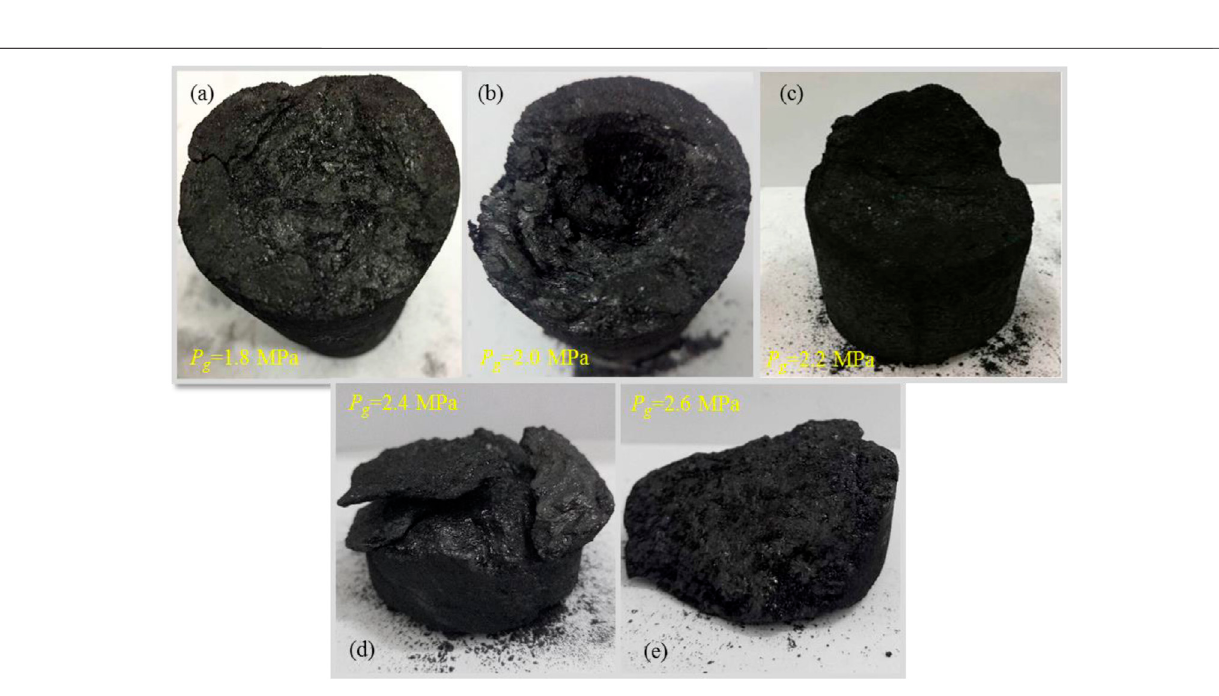
Frontiers in Earth Science |